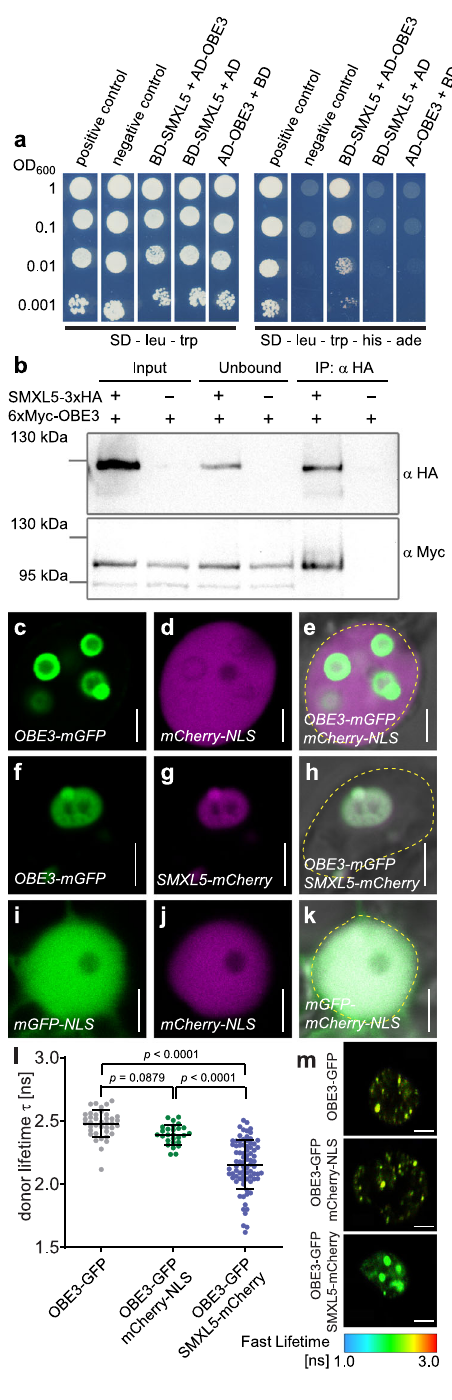
Fig.4|SMXL5andOBE3proteinsinteract.a TheSMXL5proteinwasexpressedin yeast fused to the GAL4 DNA-binding domain (BD) and OBE3 fused to the GAL4 activation domain (AD). All strains contained AD- and BD-expressing plasmids either alone or fused with SMXL5, OBE3 or control proteins, respectively. Growth onSD-leu-trpindicatethepresenceofbothplasmids,growthonSD-leu-trp-his-ade medium indicate the presence of plasmids and protein interaction. OD 600 values indicate the density of spotted yeast cultures. Positive control: yeast strain expressing SV40 large-T-antigen fused to GAL4-AD and p53 fused to GAL4-BD, negative control: yeast strain expressing lamin C fused to GAL4-BD and the GAL4- AD. b Interaction of SMXL5-3xHA and 6xMyc-OBE3 proteins by co- immunoprecipitation (co-IP) and subsequent western blot analysis after transient overexpression in N. benthamiana . “ Input ” represents unprocessed protein extracts, “ unbound ” shows proteins thatremained in the extract after IP and “ IP: α HA ” depictssamplesafterimmunoprecipitationby α -HA-beads.Westernblotswere probed by α HA or α Myc antibodies, respectively. Signals revealed an expected SMXL5-3xHAproteinsizeof~120kDa.Thesizeofthedetected6xMyc-OBE3protein (~100kDa) exceeded the expected size of 92kDa. This experiment was repeated twice.UncroppedblotsareincludedintheSourceDataFile. c – k Fluorescentsignals and bright- fi eld images of epidermal N. benthamiana nuclei transiently co- expressing OBE3-mGFP/mCherry ( c – e ), OBE3-mGFP/SMXL5-mCherry ( f – h ) and mGFP-NLS/mCherry-NLS ( i – k ). The dashed yellow line indicates the outlines of nucleiinmergedimages( e , h , k ).Scalebarsrepresent5 µ m. l FRET-FLIManalysisof transiently transformed N. benthamiana epidermal leaf cells expressing the OBE3- mGFP donor without an mCherry acceptor or in the presence of NLS-mCherry or SMXL5-mCherry. Error bars indicate standard deviation. Data were derived from three biological replicates with n =27 – 80. To test for homogeneity of variance, a Brown – Forsythe test was applied. As the variances are not homogenous a Wil- m Heatmaps of representative nuclei used for FLIM measurements. The donor lifetimes of OBE3-mGFPare color-codedaccording to the scaleat the bottom. Size bars represent 4 µ